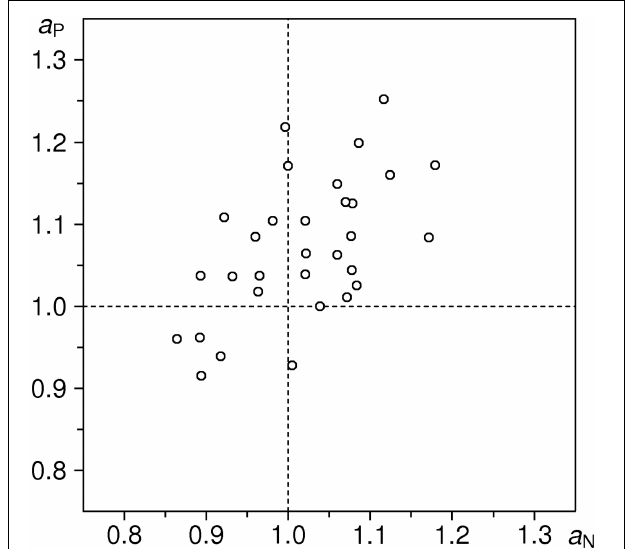
FIGURE 5 | Correlation plot of aggregated ratio indices a N versus a P ( n = 31, R = + 0 .